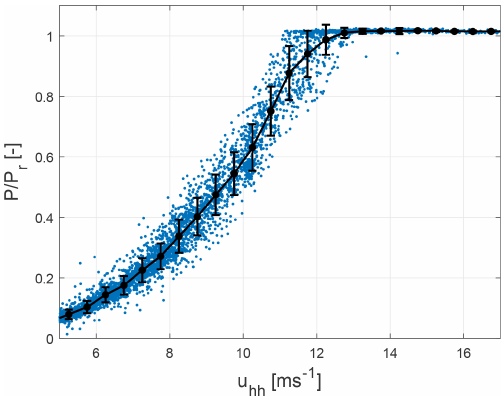
Figure 5. Normalized probabilistic power curve of wind turbine T2 with average power and its standard deviation in black for each wind speed